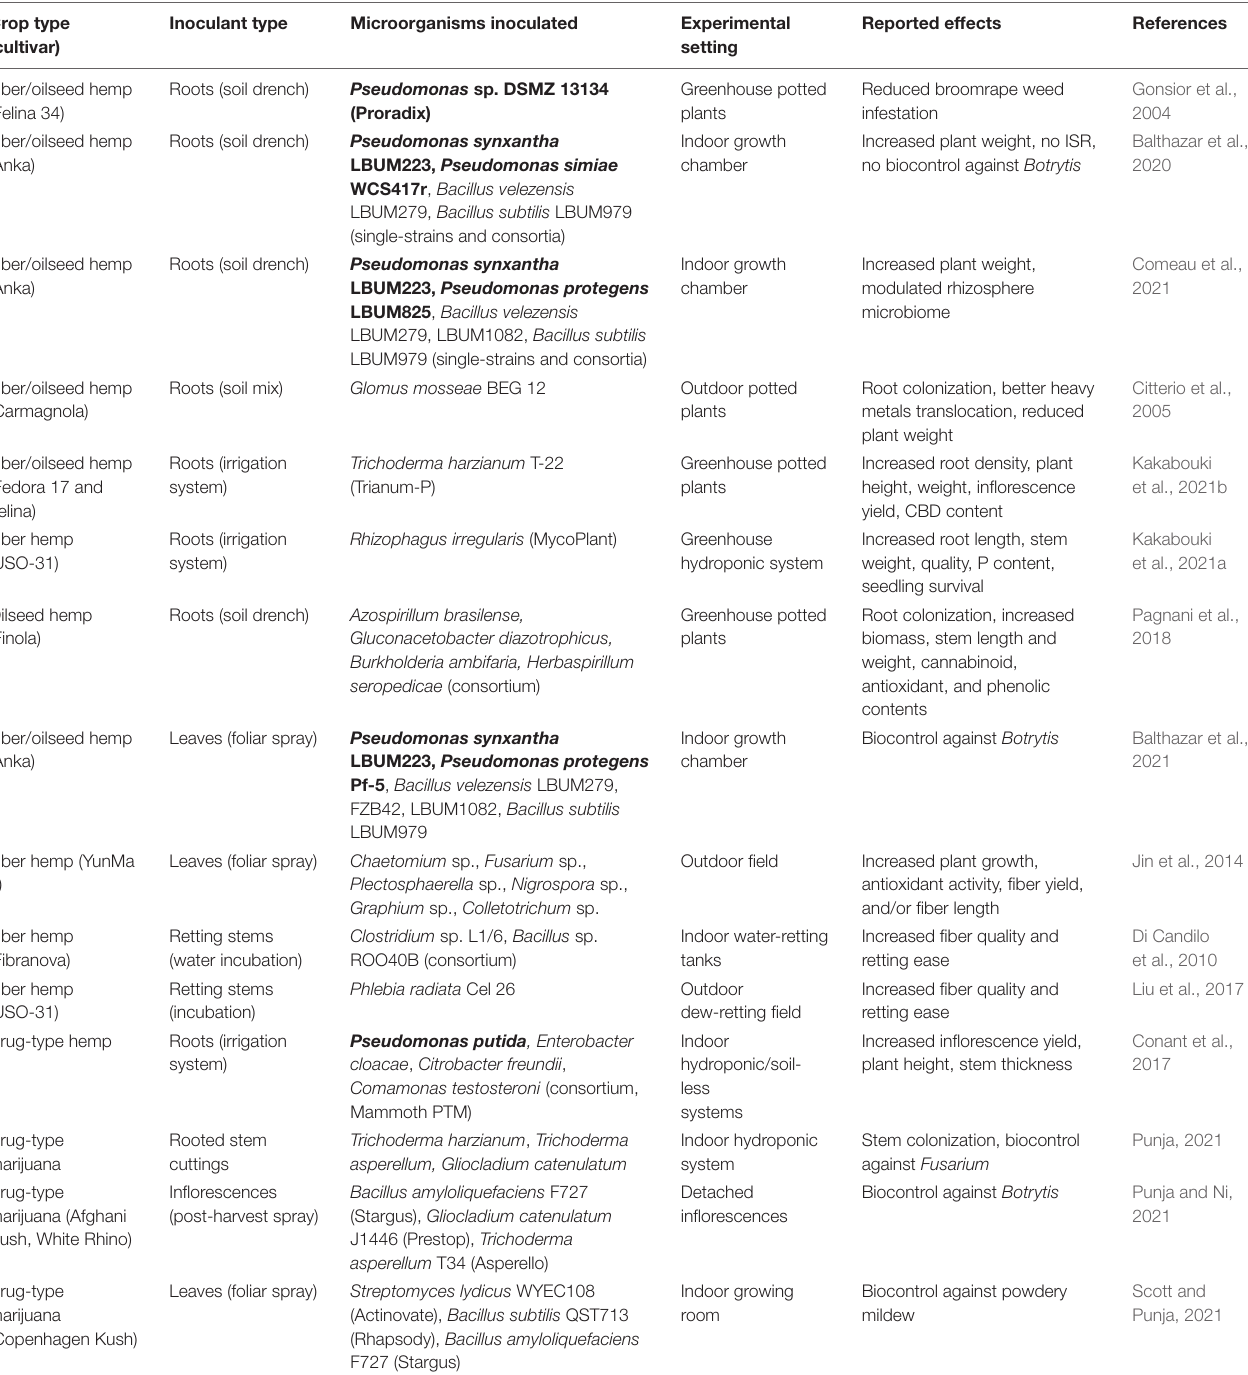
TABLE 2 | Studies using microbial inoculants with cannabis